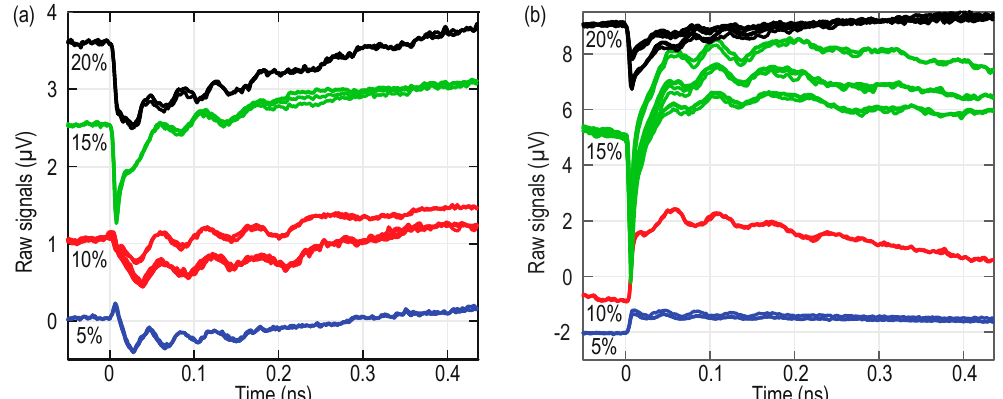
Figure 1. Raw measurements of the transient probe reflectivity in the (Bi 1 − x Pr x )(Fe 0.95 Mn 0.05 )O 3 films deposited on Si: ( a ) for probe incidence at ψ = 0° and ( b ) for probe incidence at ψ = 52°. Each percentage number denotes the Pr substitution concentration associated with the curves just above it, and each curve at a given substitution concentration corresponds to a different probed location on the sample.